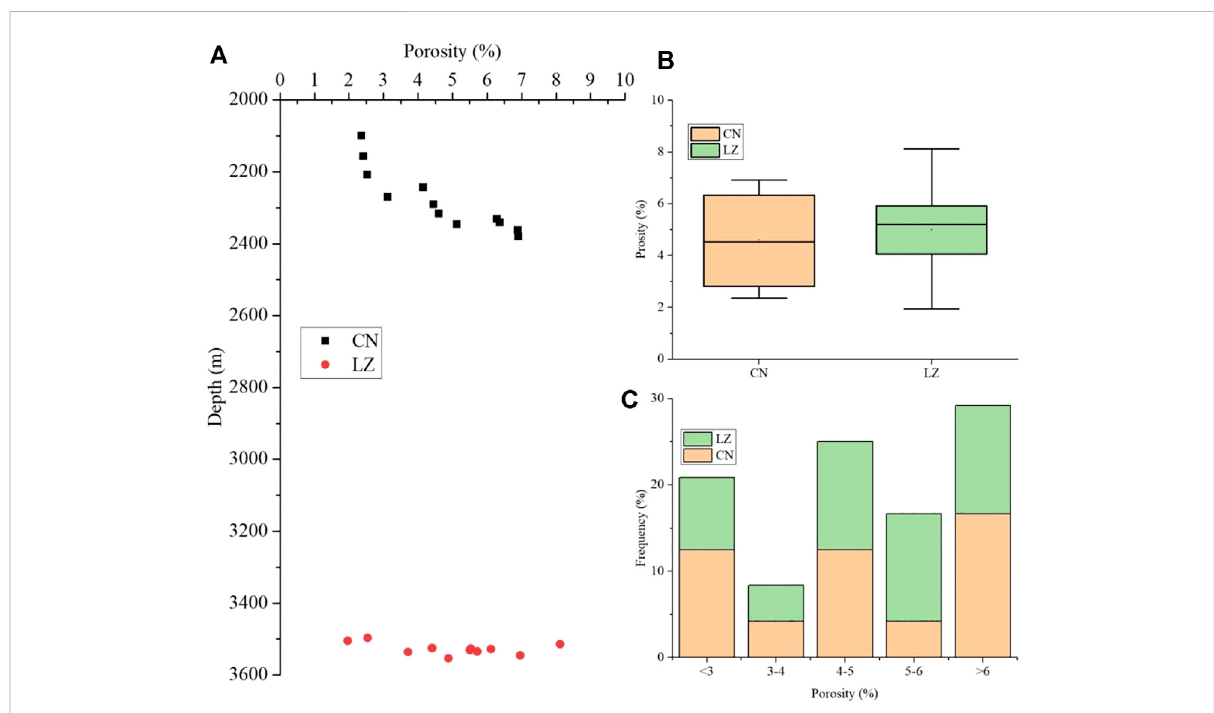
FIGURE 5 PorositydistributionoftheLongmaxiFormationshaleinthestudyarea. (A) Porosityvariationwithdepth, (B) BoxplotofporosityintheLongmaxi Formation shale in Changning and Luzhou blocks, and (C) Cumulative distribution frequency of porosity.